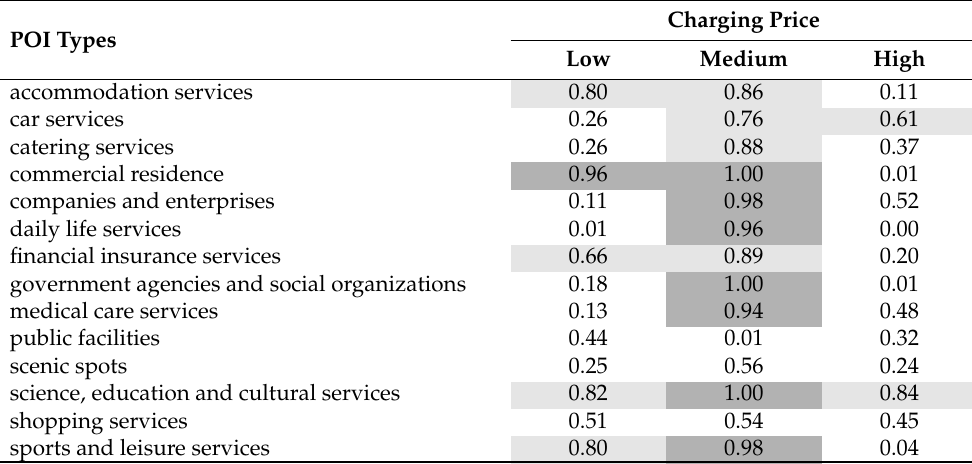
Table 4. The correlations between POIs and parking lots in different charge